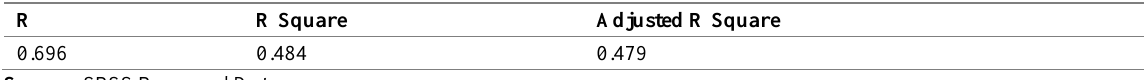
Table 8: Correlation and Determination Coefficient